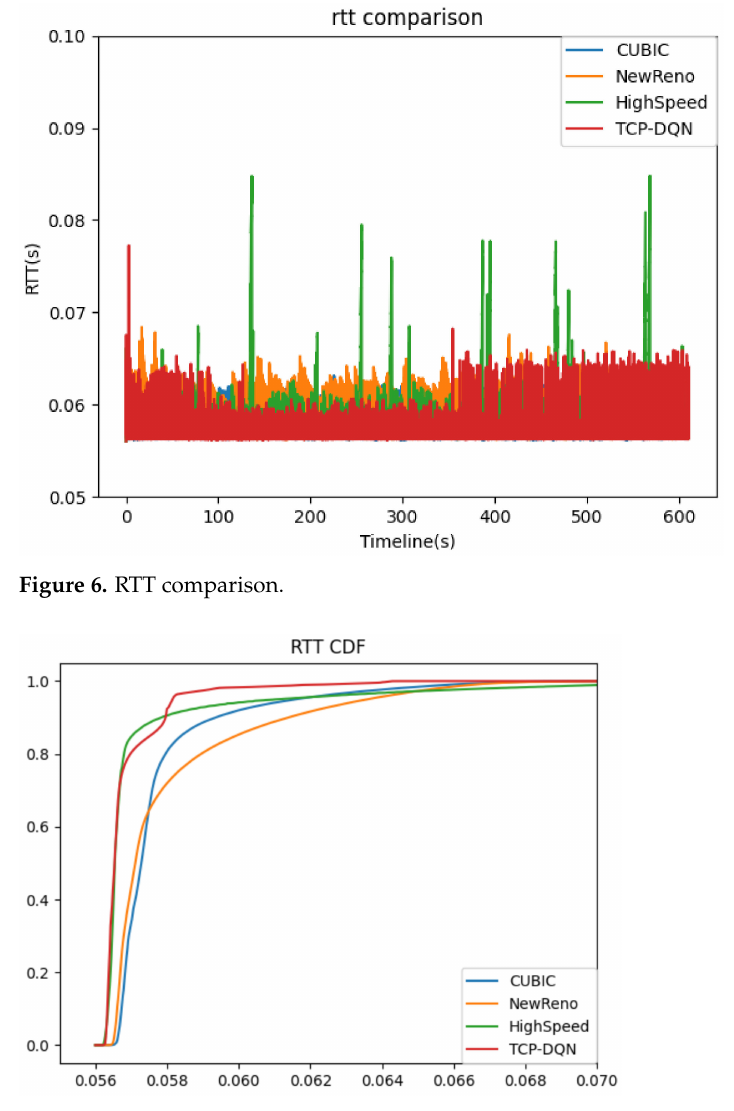
Figure 7. Throughput performance